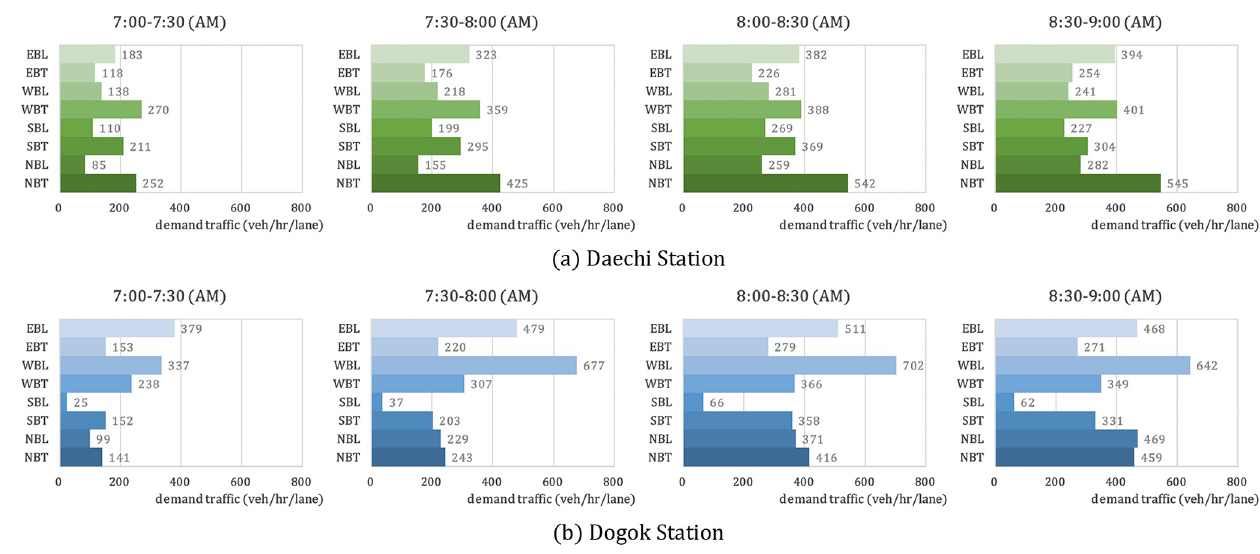
Fig 9. Actual measured traffic patterns of the simulated intersections: (a) Daechi Station and (b) Dogok Station.